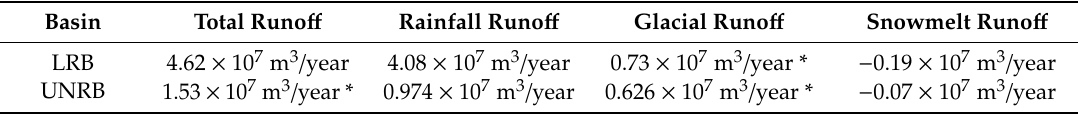
Table 5. Trends for simulated runo ff components during